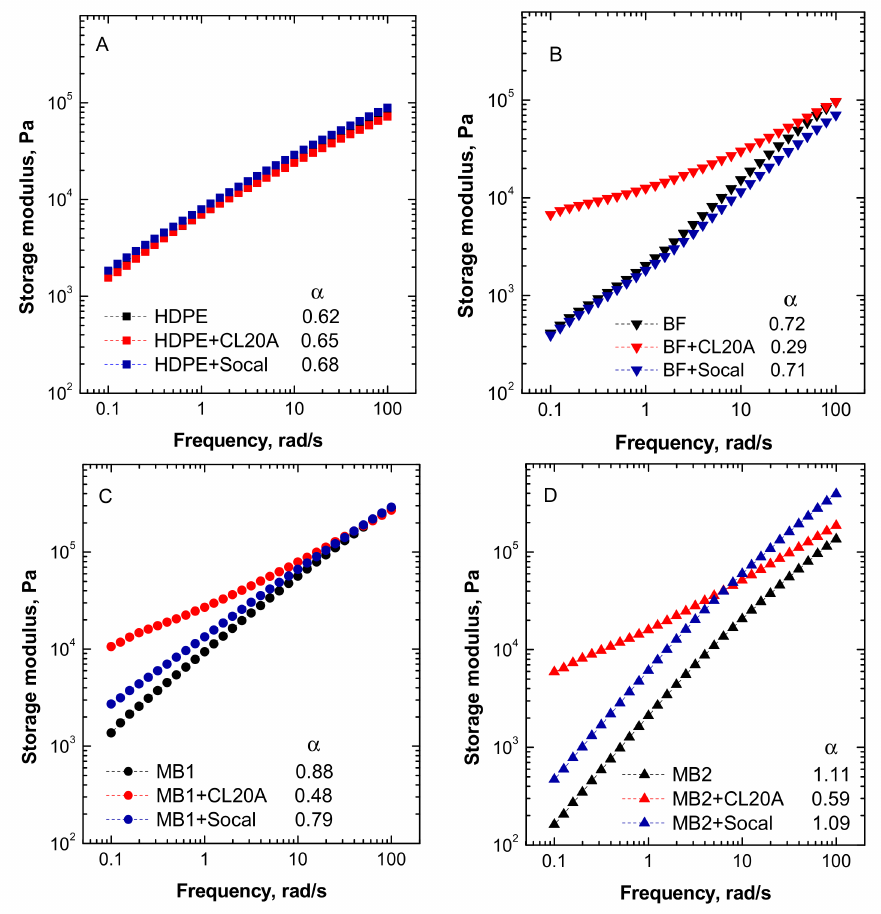
Figure 2. Storage modulus as a function of frequency for all investigated materials: ( A ) HDPE-based systems, ( B ) BF-based systems, ( C ) MB1-based systems and ( D ) MB2-based systems. In the insets, the values of the slope of the curves in the terminal region ( α ) are